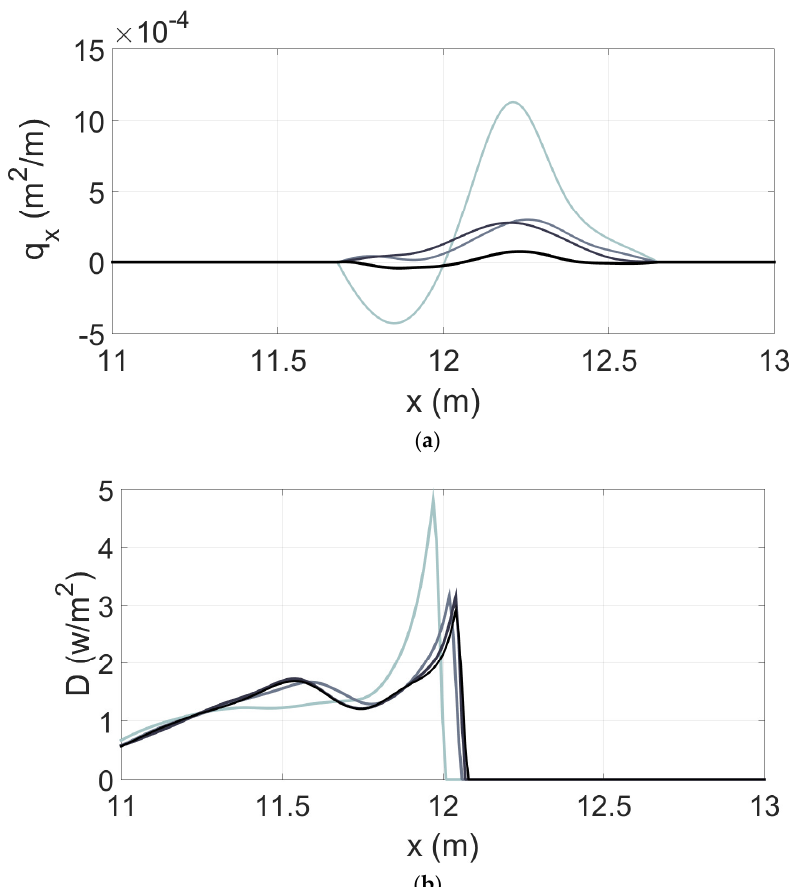
Figure 11. ( a ). Corresponding series of local sediment transport for Figure 10, in chronological order from light grey (start) to dark grey (finish). ( b ). Wave energy dissipation for the beach profiles presented in Figure 10, in chronological order from light grey (start) to dark grey (finish). To account for this issue here, a constant shift is applied to the match the location of the maxima in dissipation and maxima in transport rates (Figure 11a,b), in this case a shift of 0.18 m. Without this shift, the total transport (Figure 12b) and the berm crest elevation are still modelled well, but the location is wrong. Figure 13a,b compares the model results with and without the added shift. This comparison illustrates that the model with the ad hoc shift provides a very good match to the data (Figure 14), and the profile is both trans- lated and has a different shape with and without the shift. Nevertheless, the linking be- tween the dissipation and the local transport still provides the feedback that allows the profile to adjust dynamically over time. Errors in selected profile features are given in Table 3. The estimated model skill is BSS = 1 − (0.0046) 2 /(0.0075) 2 = 0.62, which is consider- ably lower than for the erosive conditions, but still fair.